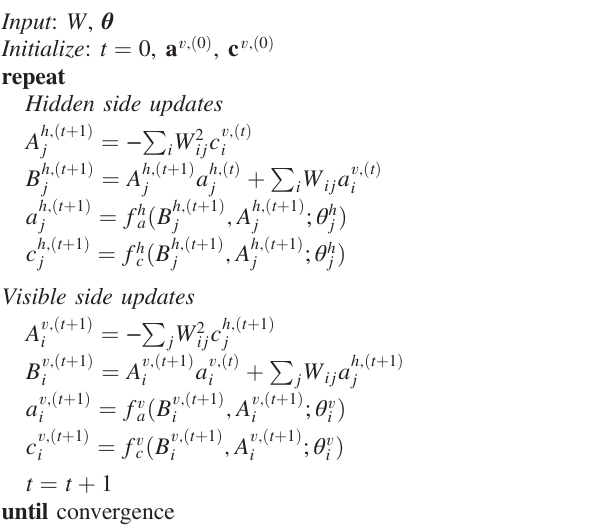
Algorithm 1. TAP inference for